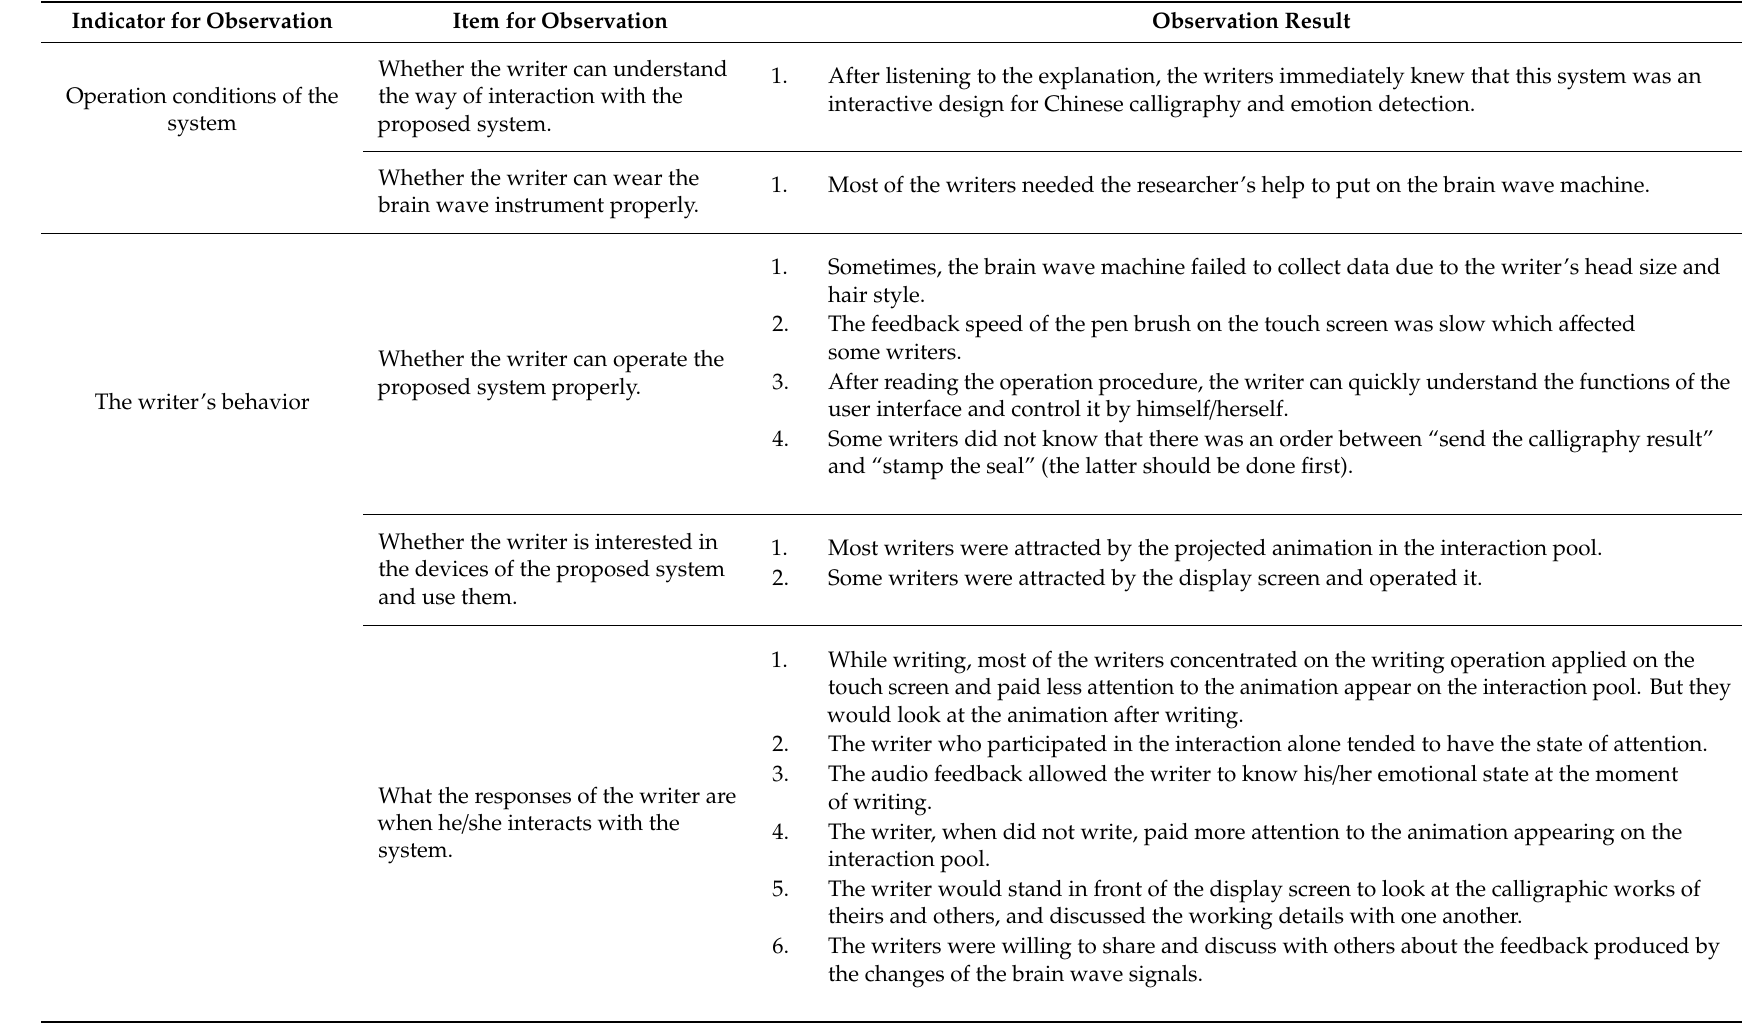
Table 10. Observation results collected from the public exhibition of the second